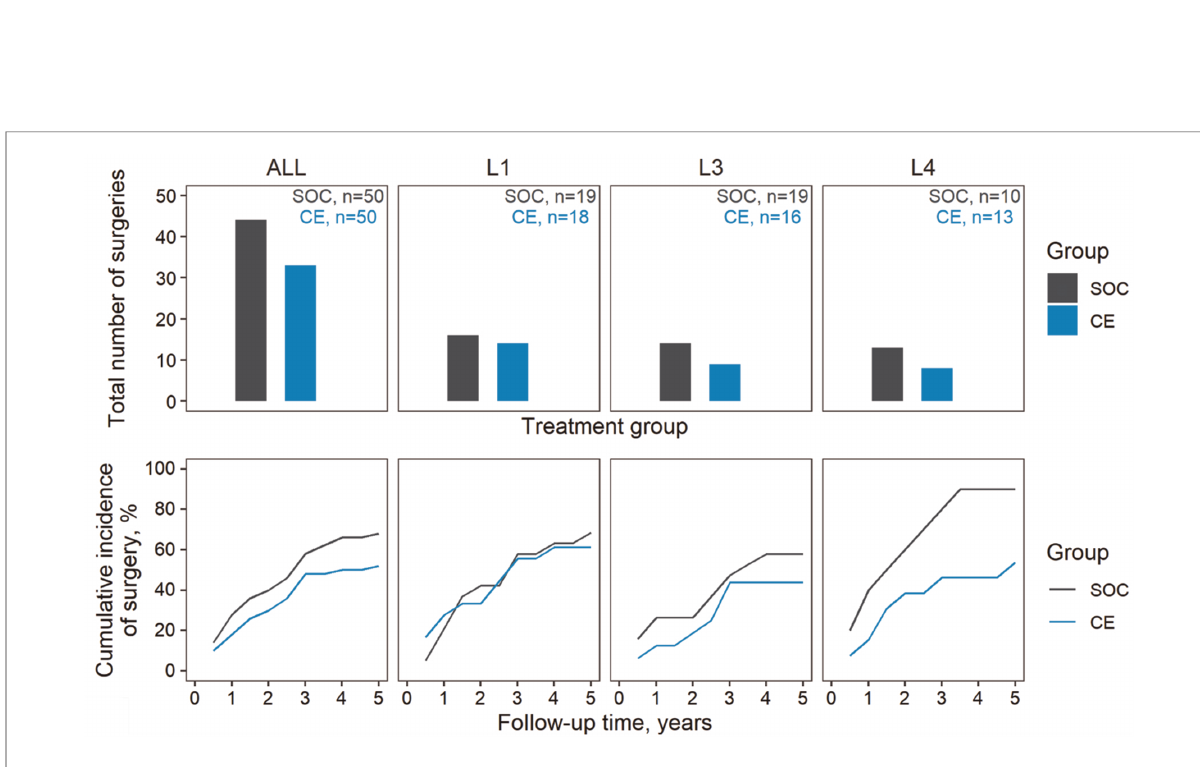
FIGURE 2 Surgery. Occurrence of surgery in the two groups. Top, cumulative number of surgeries through the fi ve-year follow-up; bottom, cumulative incidence of surgery. Results are strati fi ed horizontally by diagnosed location: ALL, all diagnosed sites; L1, L3, and L4 disease location according to the Vienna classi fi cation. Note that L2 patients were excluded due to the low